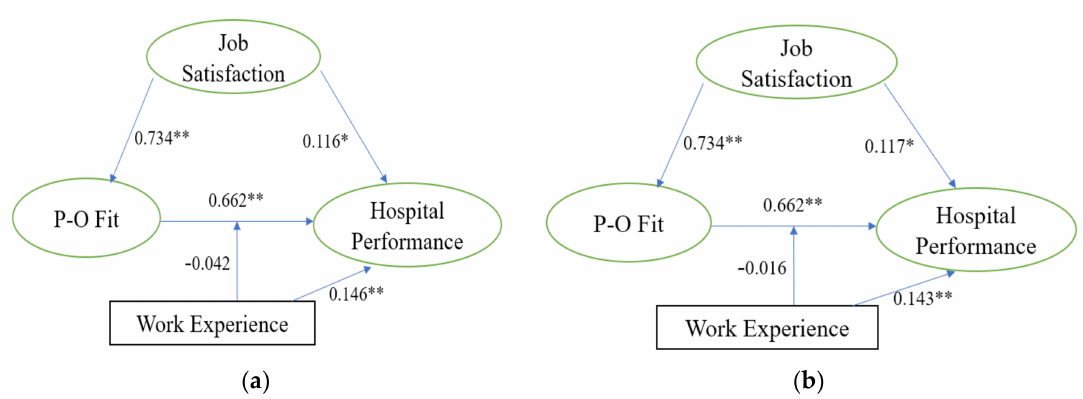
Figure A5. Work experience as a moderator for the e ff ects of job satisfaction and P-O fit (Personal-Organization fit) on hospital performance. ( a ) Moderating e ff ect of work experience on “P-O fit - > Hospital performance”: t = 1.136, p = 0.198; ( b ) Moderating e ff ect of work experience on “Job Satisfaction- > Hospital performance”: t = 0.593, p =